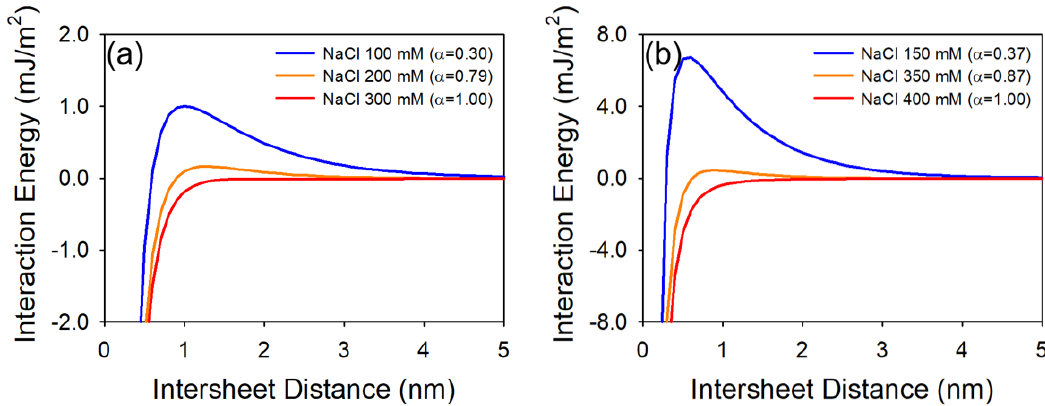
Figure 4. Derjaguin, Landau, Verwey and Overbeek (DLVO) interaction energy profiles (plate–plate geometry) of ( a ) GO and ( b ) HGO with respect to the attachment efficiency.